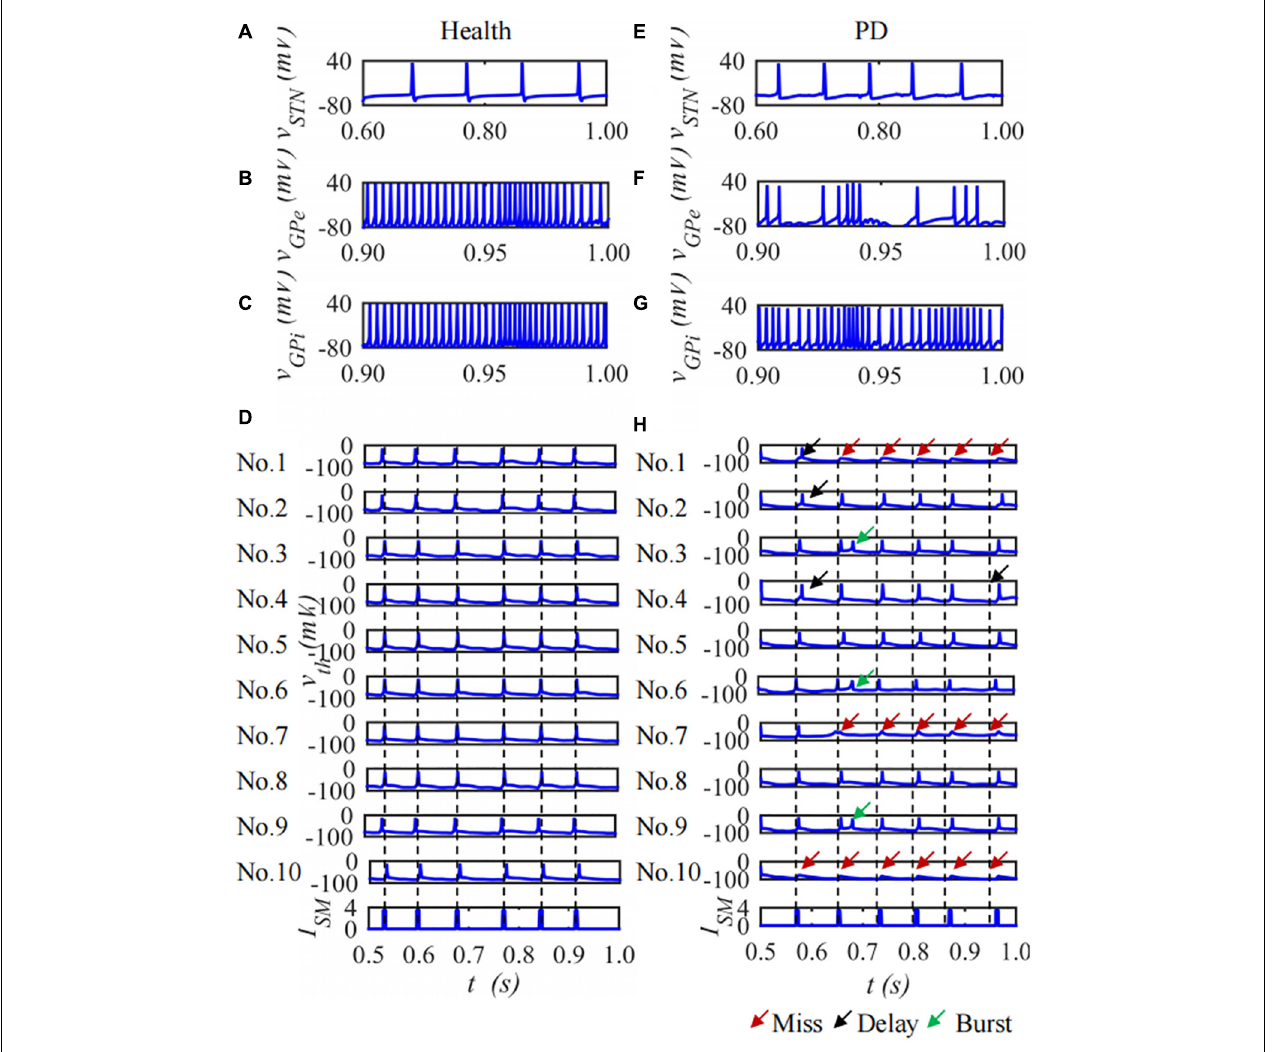
FIGURE 8 | The curve of neuron membrane potential over time, single neuron of STN, GPe, GPi and ten neurons of Th membrane potentials under (A–D) health and (E–H) PD states.